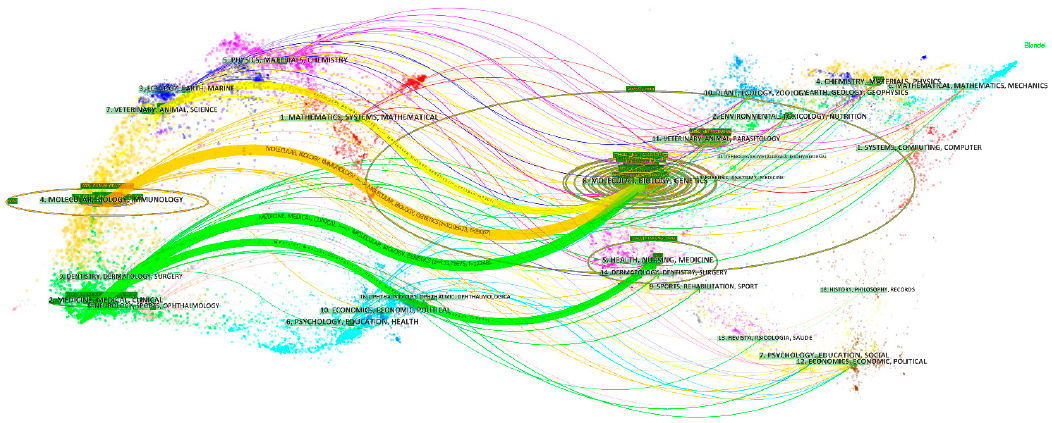
Figure 2. Dual map overlay of journals publishing research on coronavirus.